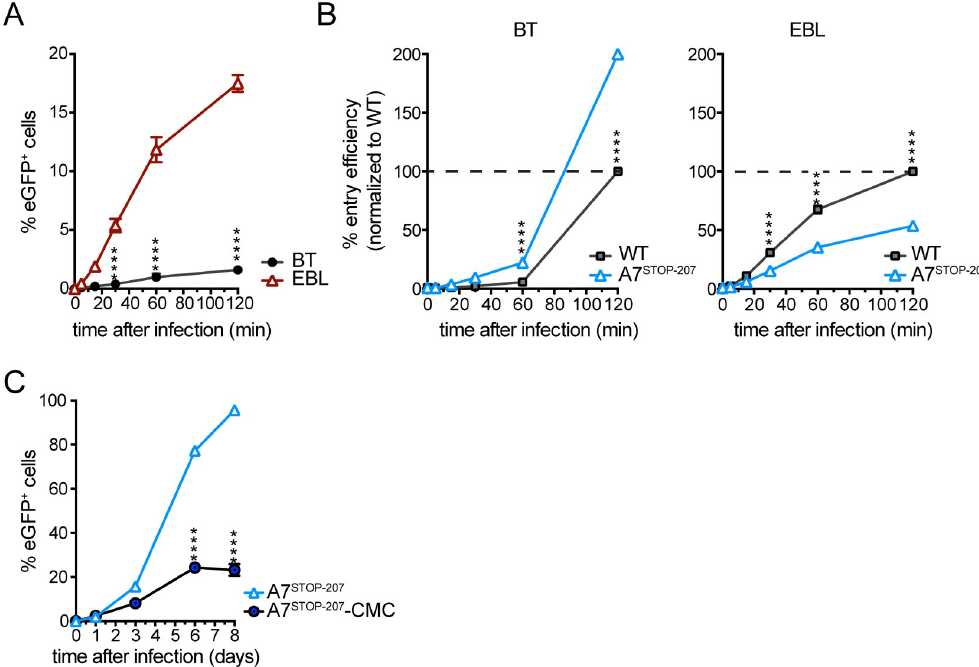
Fig 5. Infectivity assay. (A) BT and EBL cells were inoculated with eGFP-expressing C500 BAC + WT (m.o.i. = 0.05 PFU/ cell) for the indicated times and then washed with PBS and cultured overnight. Viral infection was assayed 20 h later by flow cytometry for eGFP expression. (B) BT and EBL cells were inoculated with eGFP-expressing C500 BAC + WT or BAC + A7 STOP-207 (m.o.i. = 0.05 PFU/cell) for the indicated times and then washed with PBS and cultured overnight as in (A). Plotted data represent entry efficiency as the normalized percentage of C500 (WT) virus after 120 min incubation. (C) Viral propagation of BAC + A7 STOP-207 (m.o.i. = 0.01 PFU/cell) in BT cells cultured in medium or medium containing 0.6% (w/v) CMC). Data are displayed as mean ± SEM of measurements in triplicates. Two-way ANOVA with Sidak’s post-hoc test was used to identify significant differences ( ���� P <